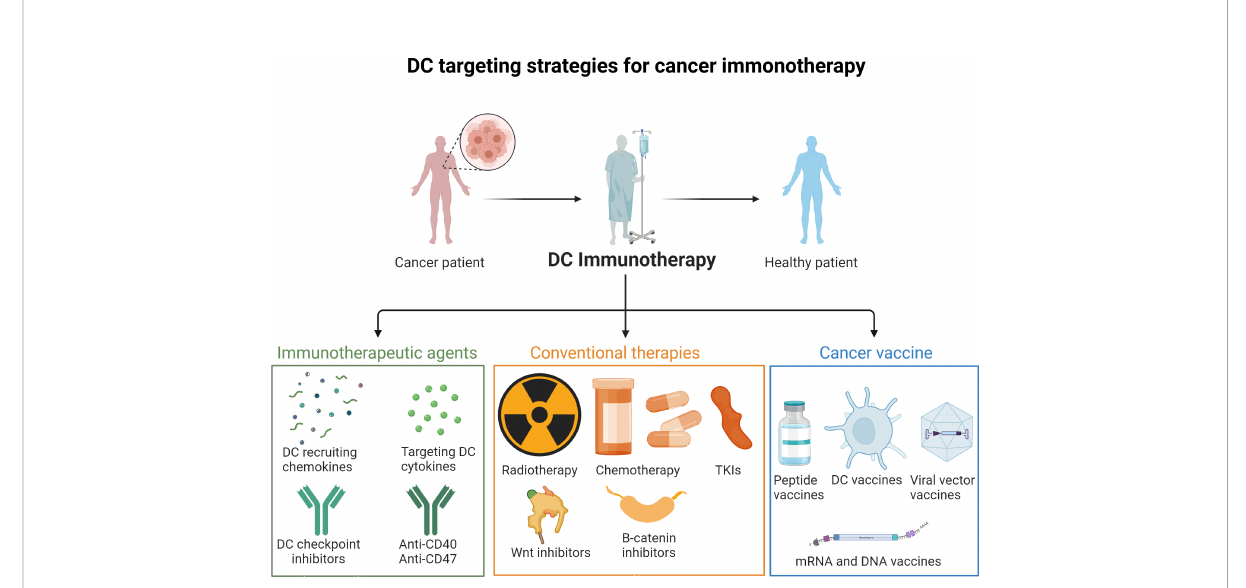
FIGURE 3 DC targeting strategies for cancer immunotherapy. Strategies to overcome DC impairment and recruitment in the TME include immunotherapeutic agents (DC checkpoint inhibitors, DC recruiting cytokines and mobilizing agents), conventional therapies (radiotherapy, chemotherapy, TKIs, Wnt, B-catenin and in fl ammasome inhibitors), and cancer vaccines (mRNA, DNA, peptide and DC